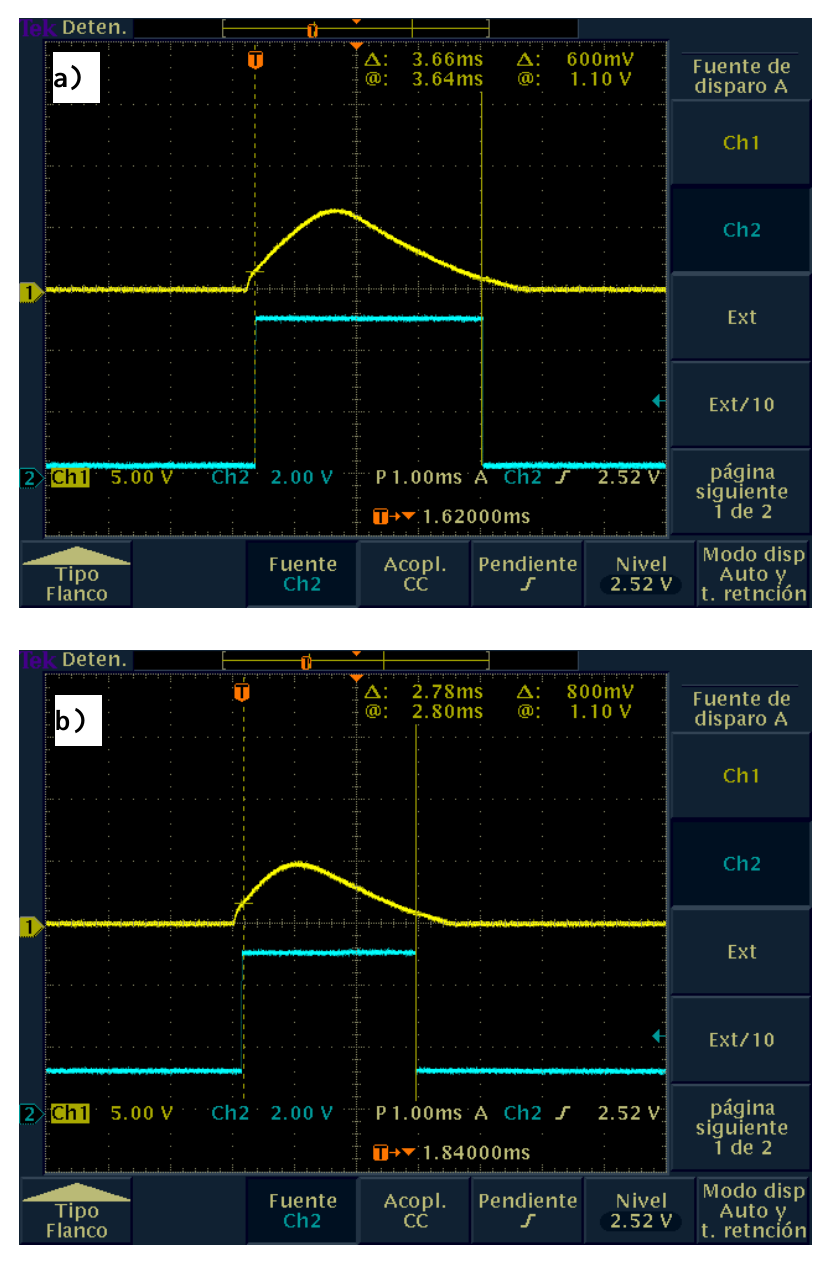
Figure 9. POS output signal amplitude variation according to rpm on mirror